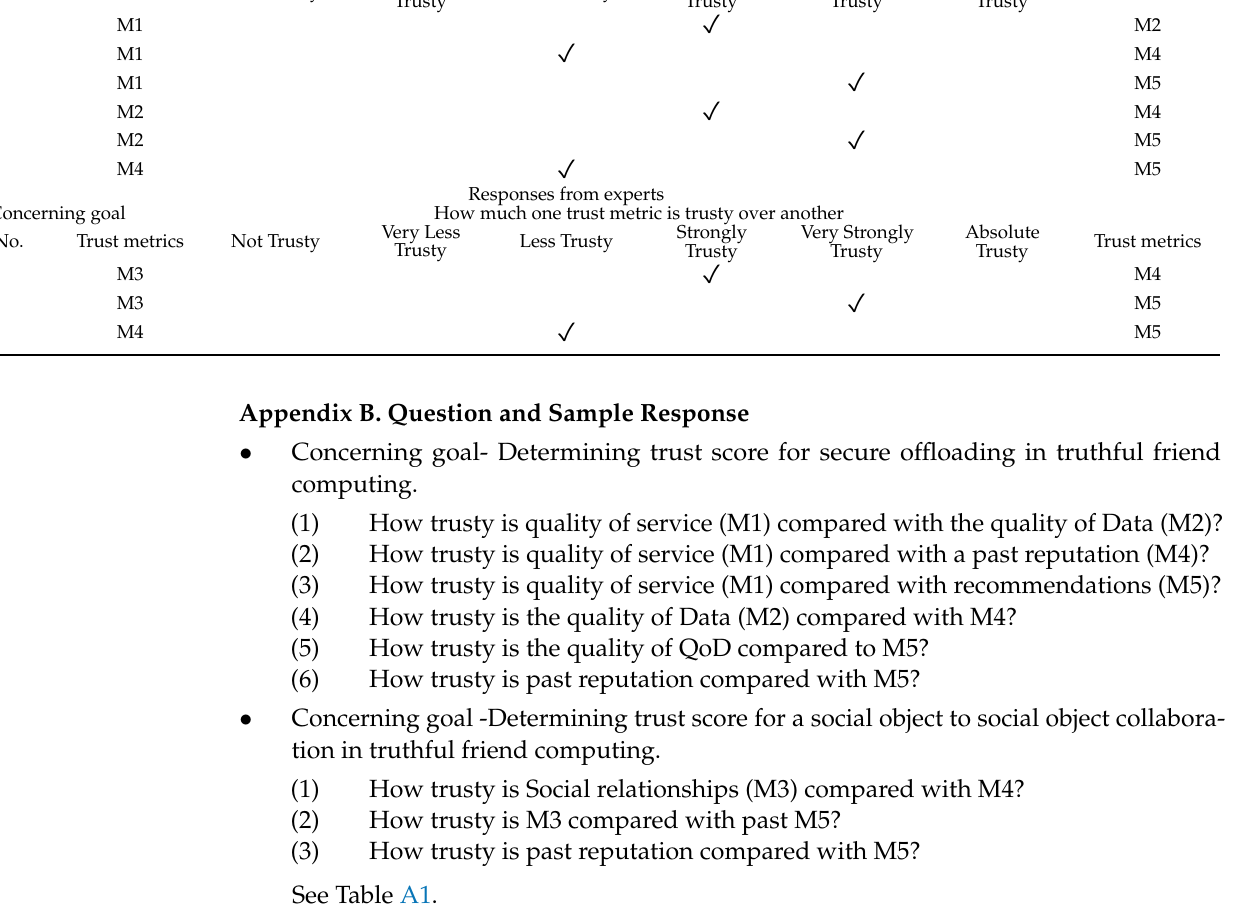
Table A1. Sample responses.